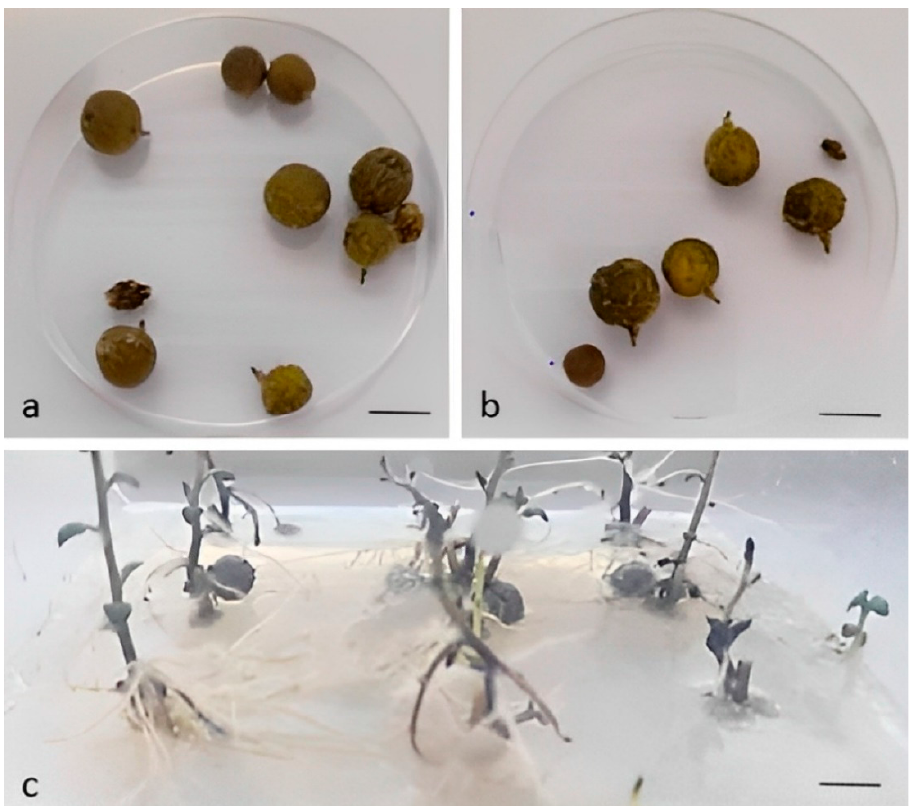
Figure 2. Microtubers produced in one container of a clone infected with PVM ( a ) or with both viruses, PVM + PVS ( b ); microtuberization under short-day conditions ( c ); bar = 1 cm.